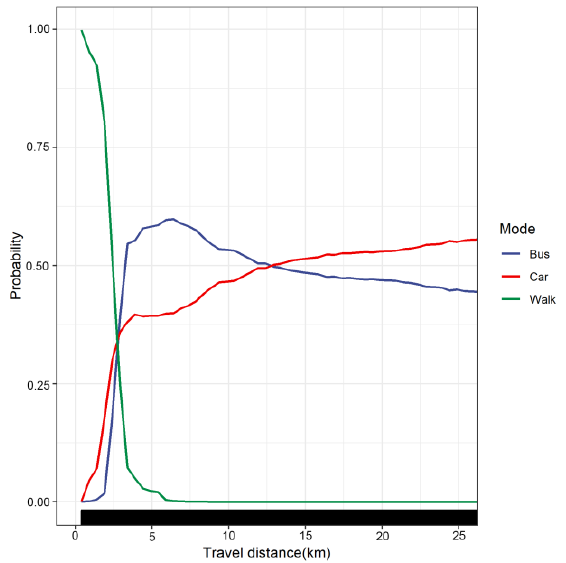
Figure 6. Nonlinear effect of travel distance on travel mode choice.